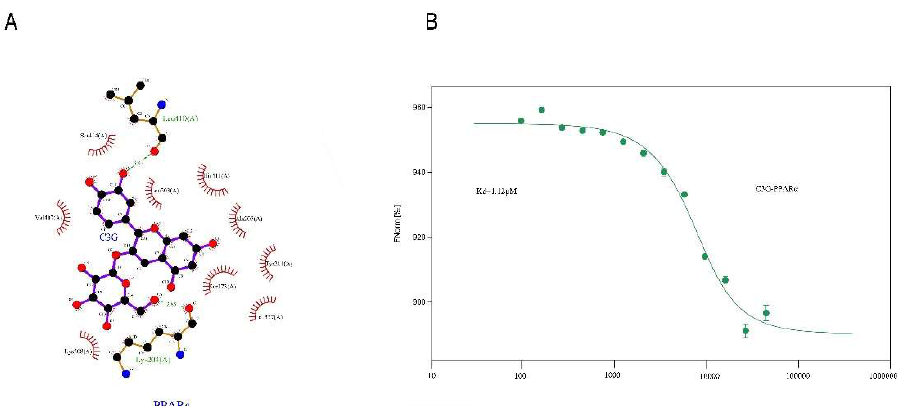
Figure 6. Conformational investigation and interaction study of PPAR α –C3G ( A ).The molecular visualization system predicted the binding conformation of ppar α to C3G. ( B ) MST technique to quantitate the affinity of ppar α for C3G molecular interactions. The final C3G was added at varying concentrations (ranging from 5 μM to 23,000 μM).